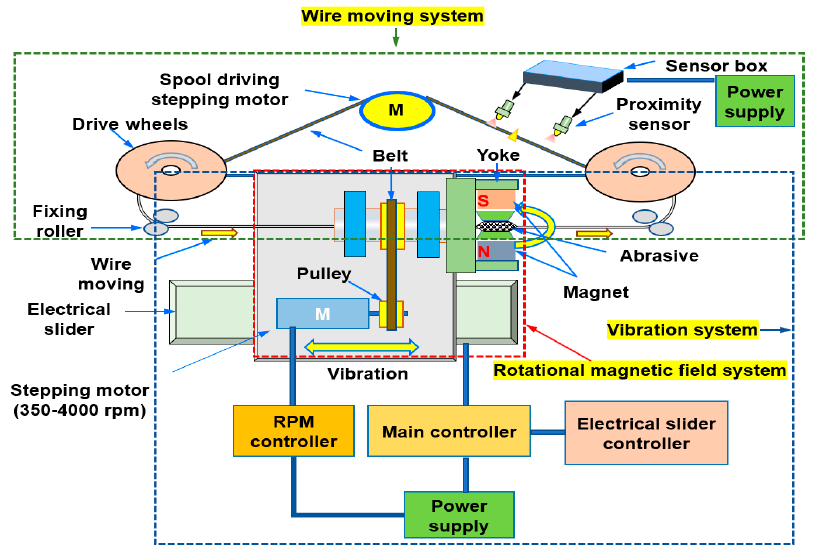
Figure 1. Experimental setup of magnetic abrasive finishing process for beta-titanium wire. Appl. Sci. 2020 , 10 , x FOR PEER REVIEW